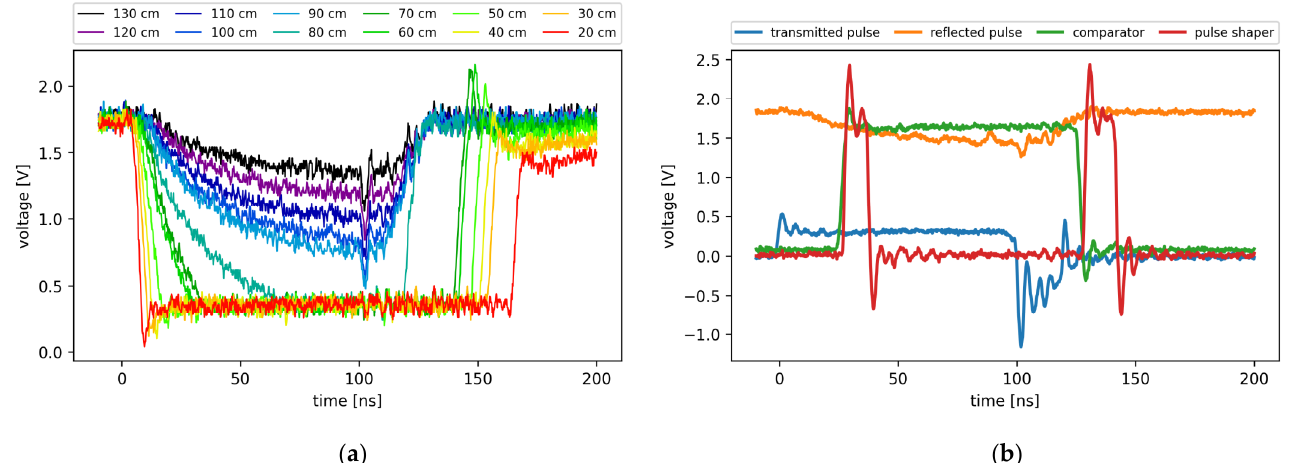
Figure 4. ( a ) Reflected pulse after TIA at different target distances, measured after receiving TIA. All pulses are synchronized to the rising edge of the transmitted pulse. ( b ) Pulse shape of the transmitted pulse, as measured on the shunt resistor (blue), reflected pulse, as measured after TIA (orange), pulse shape after the first comparator (green, and the pulse pair after the pulse shaper (red). The comparator’s and the pulse shaper’s waveforms were attenuated by 50%.